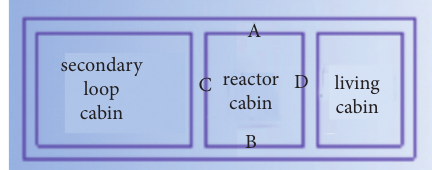
Figure 3: Floating nuclear power plant platform